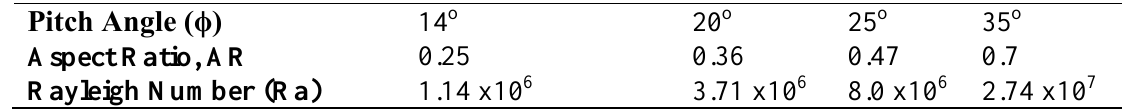
Table 1. Parametric details of the